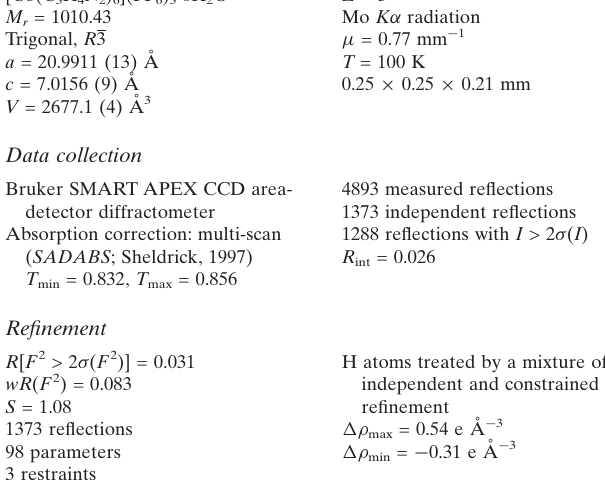
Bruker SMART APEX CCD area- detector diffractometer Absorption correction: multi-scan ( SADABS ; Sheldrick, 1997)